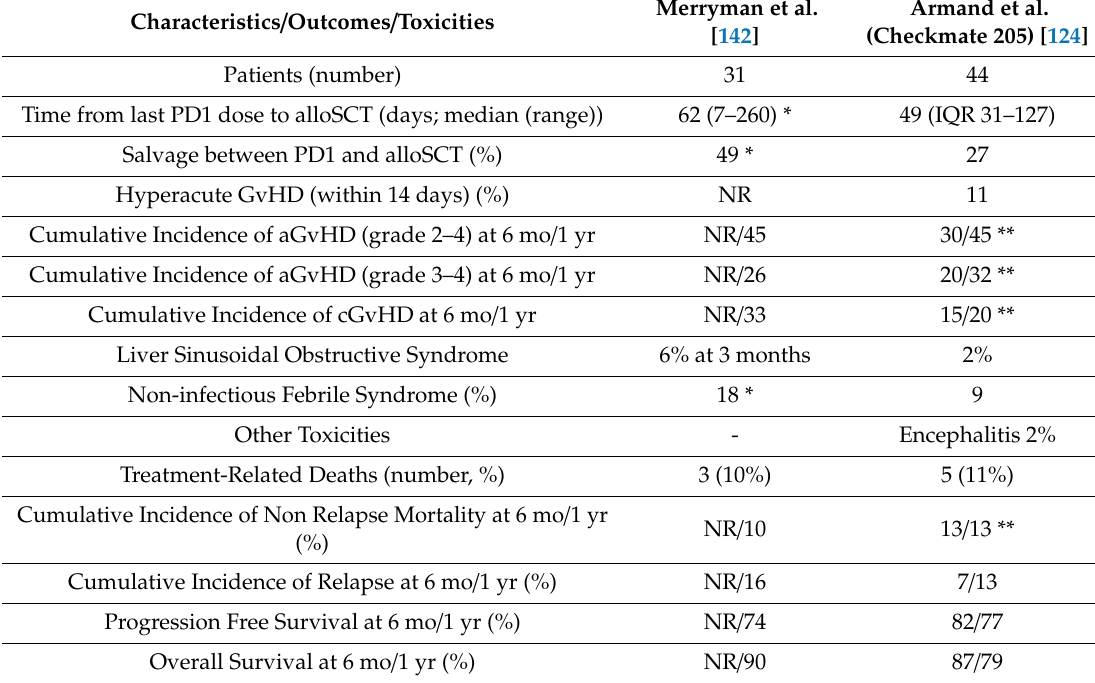
Table 10. Outcomes and toxicity of alloSCT after exposure to checkpoint inhibitors. Characteristics / Outcomes / Toxicities